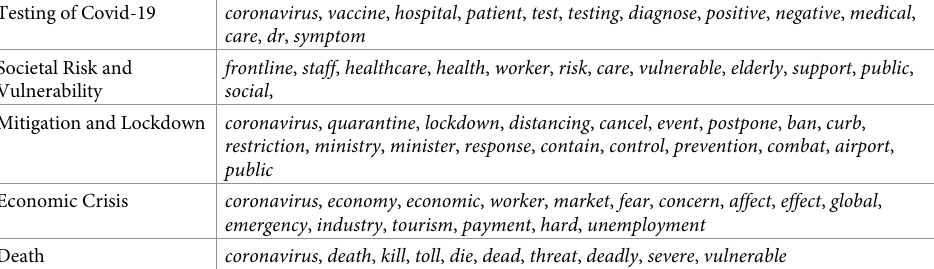
Table 3. Peak pandemic topics and collocates. Testing of